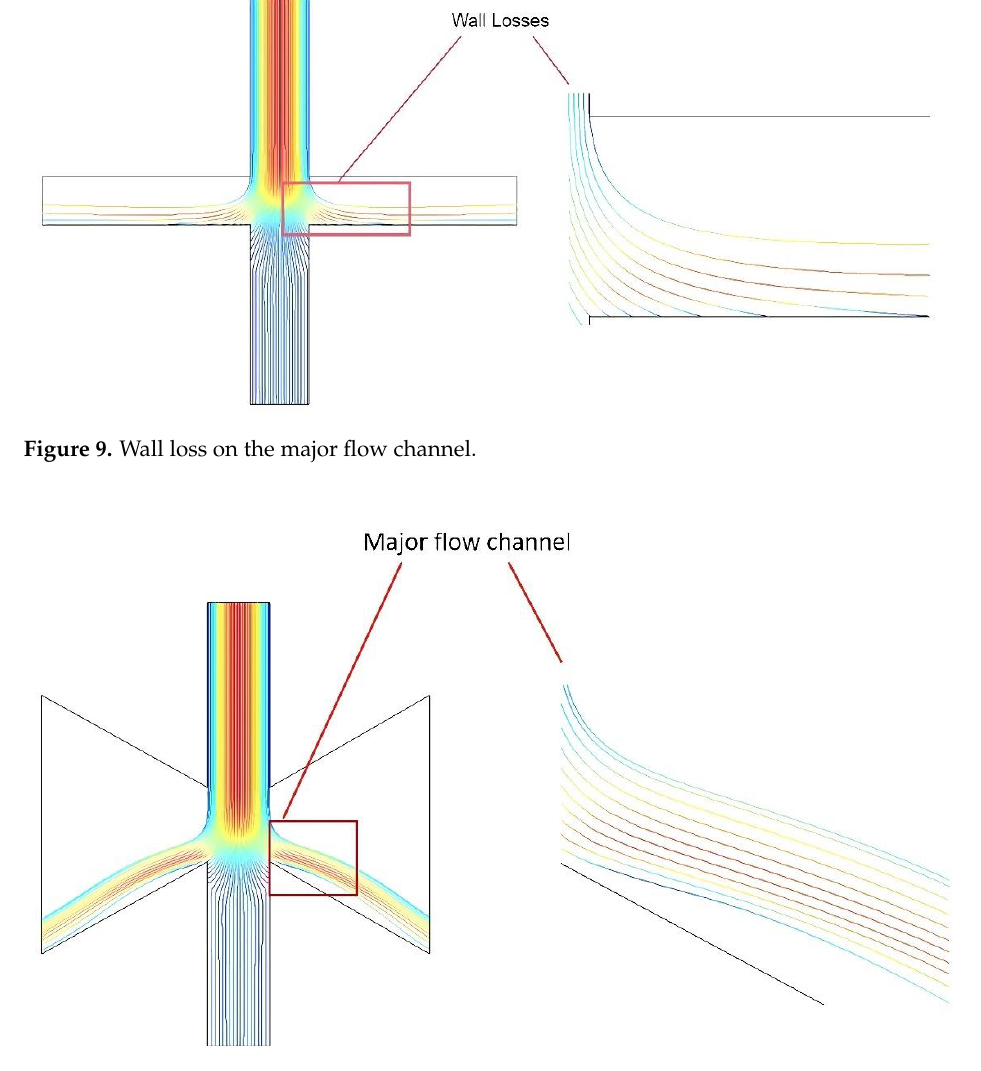
Figure 10 . Trapezoidal major flow channel particle motion trajectory . Figure 10. Trapezoidal major flow channel particle motion